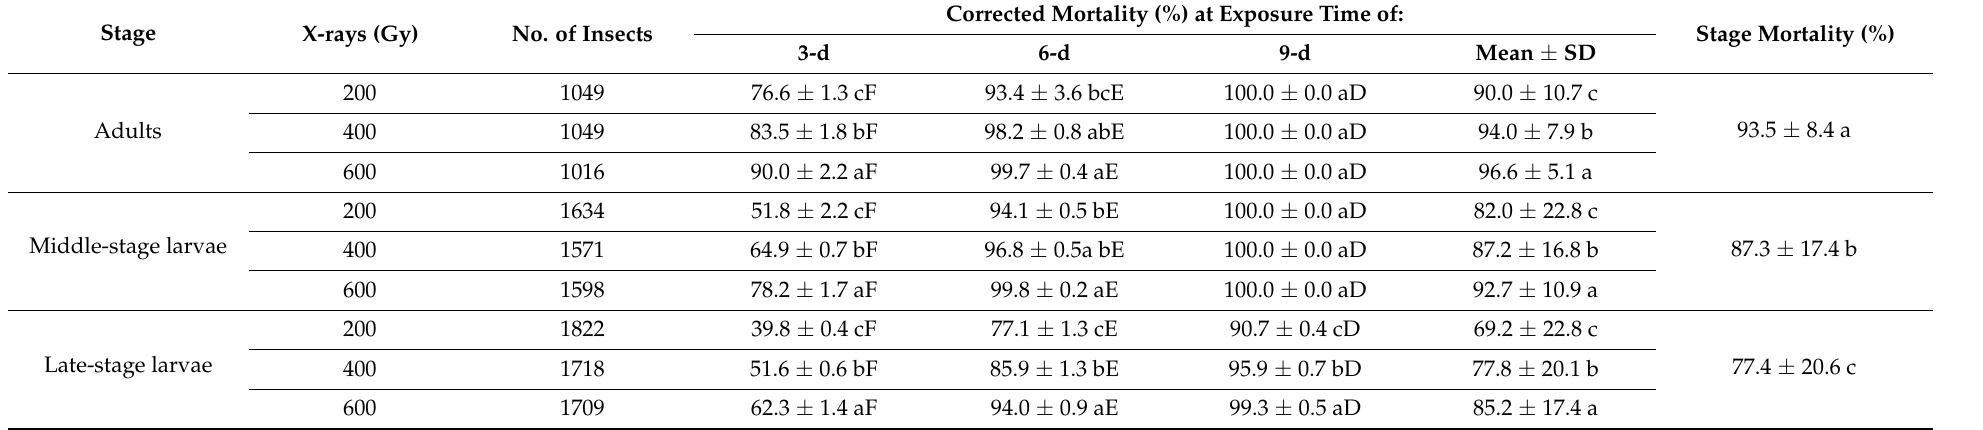
Table 2. Mortality of T. granarium adult and larvae treated at 24–26 °C under 1% O 2 atmosphere for the exposure times of 3, 6, and 9-d after 200, 400, and 600 Gy X-rays irradiation.